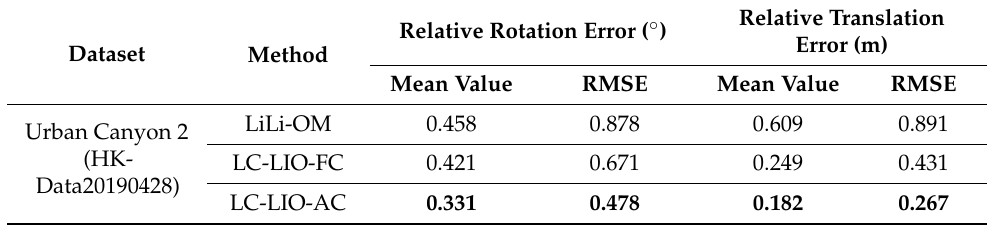
Table 2. RPE of LiLi-OM, LC-LIO-FC and LC-LIO-AC produced by EVO [40] on urban canyon 2. The bold values represents best precision.